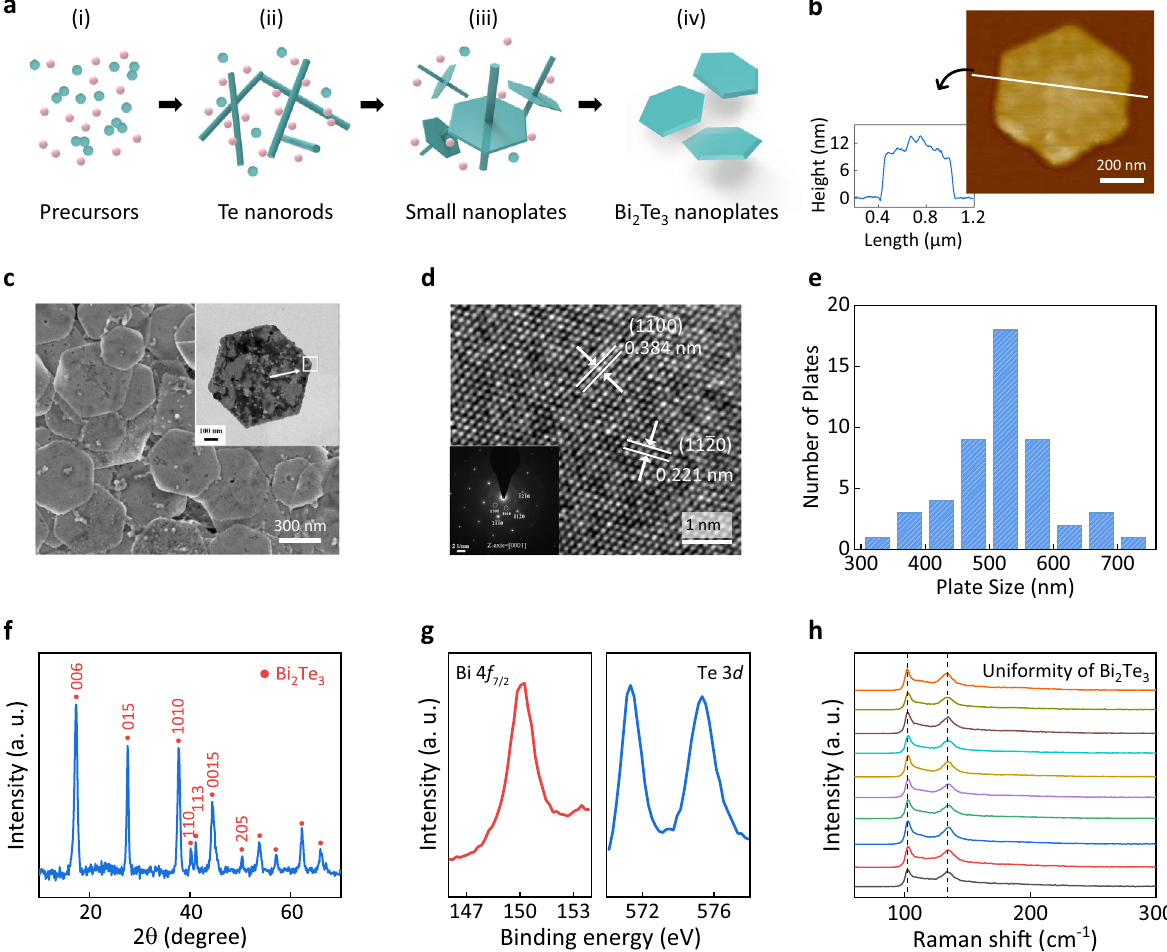
Fig. 1 Materials characterization of Bi 2 Te 3 NPs. a Schematic illustration of growth mechanism for Bi 2 Te 3 NPs. b AFM image of a Bi 2 Te 3 NP and the corresponding height/width pro fi le along the solid line across the nanoplate. c SEM and TEM images (inset) of the hexagonal Bi 2 Te 3 NPs. d HRTEM image of Bi 2 Te 3 sample and the corresponding SAED image with bright hexagonally symmetric spots. e Statistic of the size distribution of Bi 2 Te 3 NPs by AFM analysis. f XRD pattern of the fabricated Bi 2 Te 3 NPs. g High-resolution XPS spectra of Bi 4 f and Te 3 d region, respectively. h Raman spectra were collected from stochastic sites on an individual Bi 2 Te 3 NP. Source data are provided as a Source Data fi triboelectric layers and electrodes, respectively. The schematic diagrams of the crystal structure and energy band of Bi 2 Te 3 in Fig. 2b(i) highlight its building block — quintuple layer (QL) and the unique surface conductive features. Each QL cell consists of fi ve layers, which are stacked by a sequence of Te(1) – Bi – Te(2) – Bi – Te(1) along the z-direction and terminated by a Te(1) layer at both ends. Compared with the strong interaction within each QL cell, the van der Waals force between adjacent QL cells is much weaker, leading to the preferential cleave surface of Te atomic layer 38,49,53,54 . The preparation procedures are described in detail in the supporting information (Supplementary Fig. 1). SEM images in Fig. 2b show two different surface morphologies for the Bi 2 Te 3 fi lm assembled by NPs (Bi 2 Te 3 -NP fi lm), revealing that its compactness and regularity closely depend on the coating dosage of Bi 2 Te 3 NP colloid. Figure 2c presents the one-cycle voltage outputs of TI-TENG and triboelectri fi cation and electrostatic induction effects 55 . In the fi tribolayers leads to charge transfer from the Bi 2 Te 3 -NP fi lm to Kapton when making contact. When they are brought away from each other (second stage), electrons fl ow from the bottom